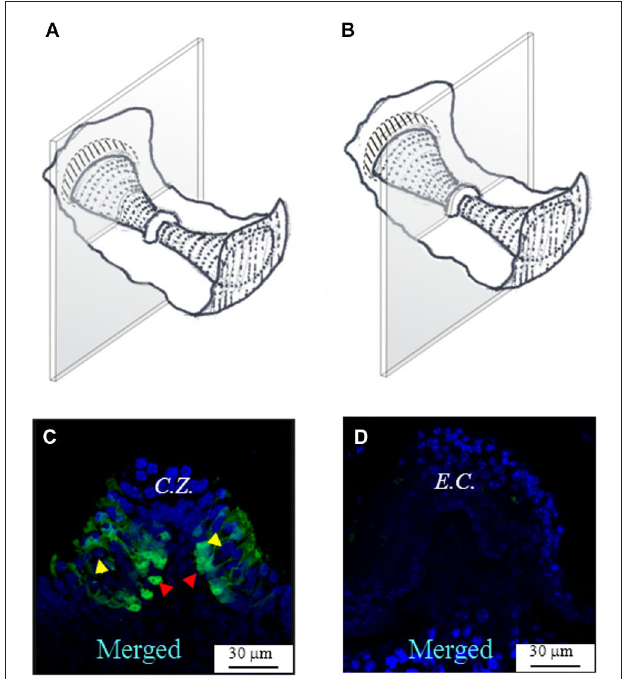
FIGURE 3 | GAD67 expression in transverse slices of the mouse vertical crista . (A,B) Schematic representations showing the plane of the transverse sections. (C,D) Photomicrographs of the confocal sections showing the expression of GAD67. C.Z. : central zone. Note the absence of GAD67 at the most central zone in (C) , and the complete absence of GAD67 in the E.C. in (D) . The red arrowheads indicate the position of supporting cell nuclei, while the yellow arrowheads the position of hair cell nuclei.